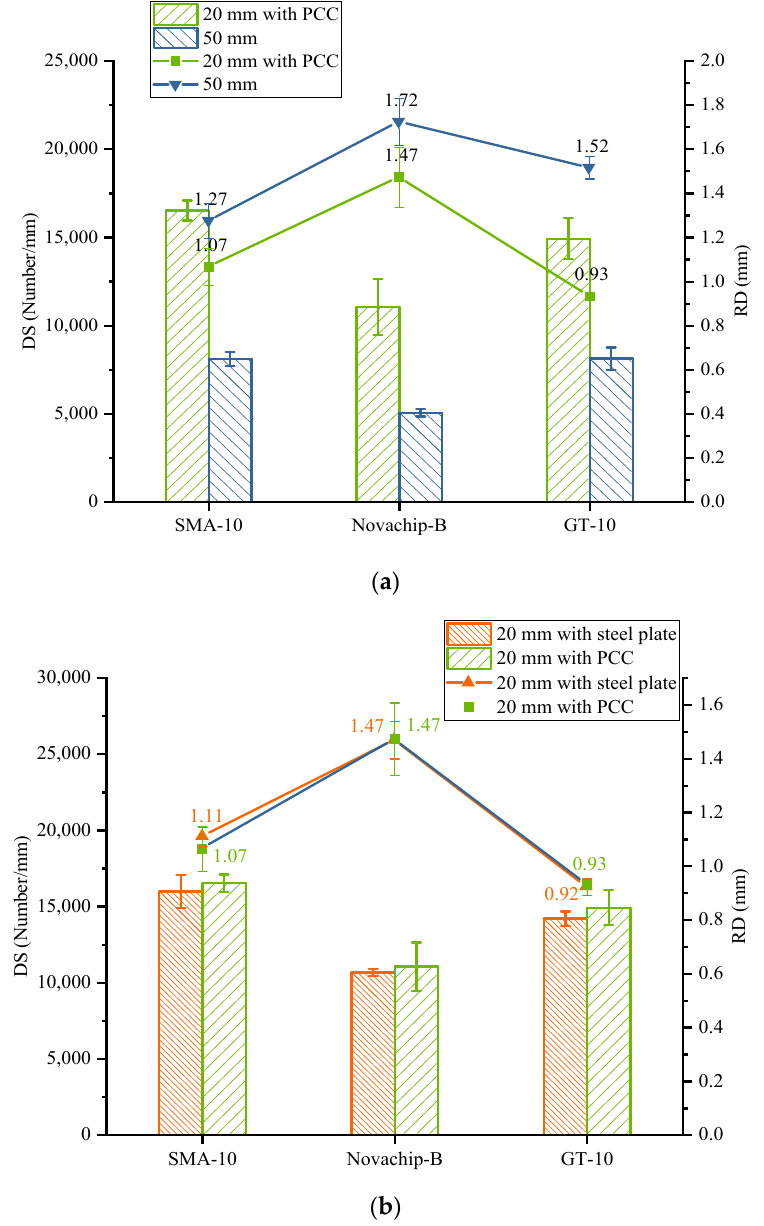
Figure 11. Rutting results: ( a ) UTWC specimens of 50 mm and 20 mm with PCC slab; ( b ) UTWC specimens of 20 mm with steel plate.